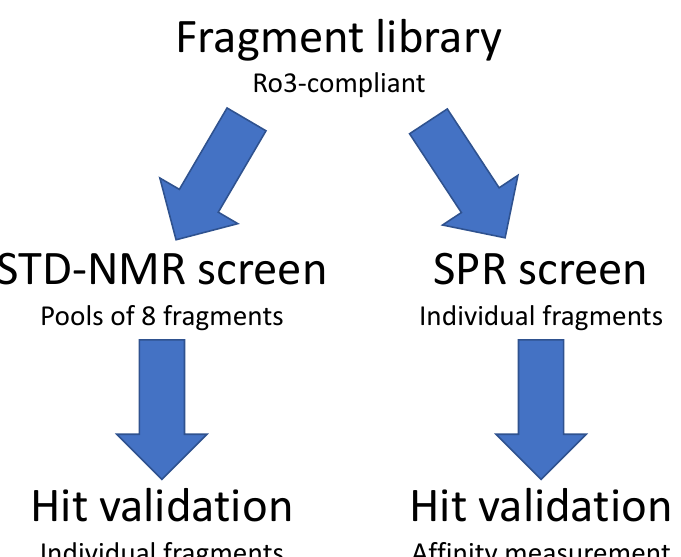
Figure 1. Fragment screening strategy to identify fragments that bind Epstein–Barr nuclear antigen 1 (EBNA1) and KSHV latency-associated nuclear antigen (LANA). STD–NMR, saturation transfer difference–NMR; SPR, surface plasmon resonance.